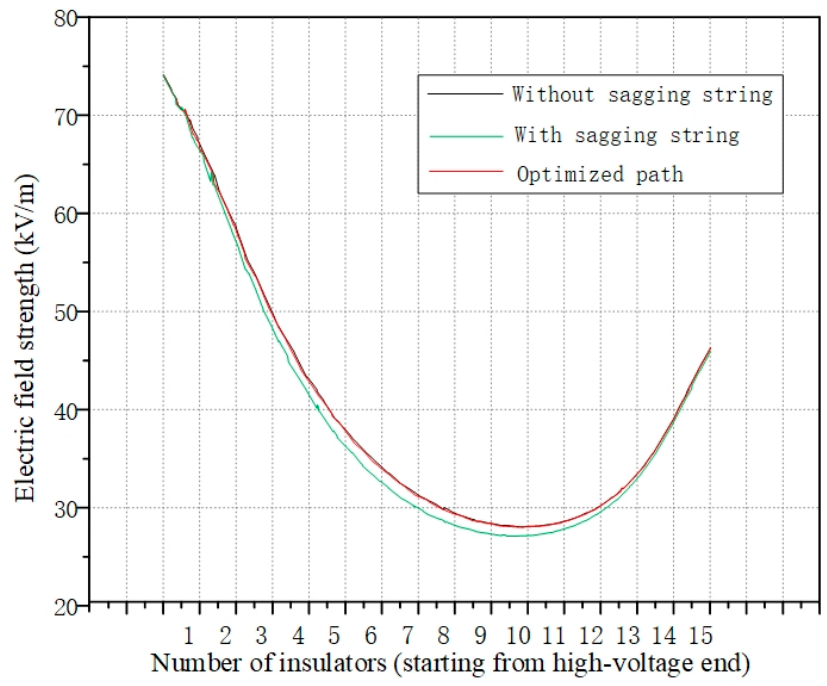
Figure 10. The electric field curve of the insulator under the effect of sag.